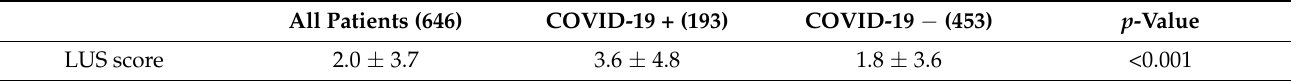
Table 3. LUS scores differentiated by SARS-CoV-2 nasal swab result; continuous variables are expressed as mean ± standard